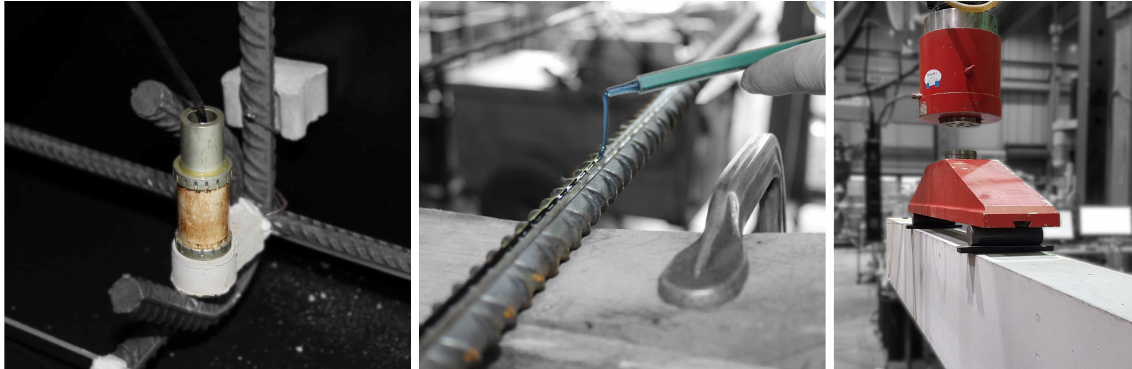
Figure 5. ( Left ): US transducer attached to the reinforcement with a quick-cement fastener. ( center ): Gluing a FOS to the rebar. ( right ): Beam before the experiment in the test bench.